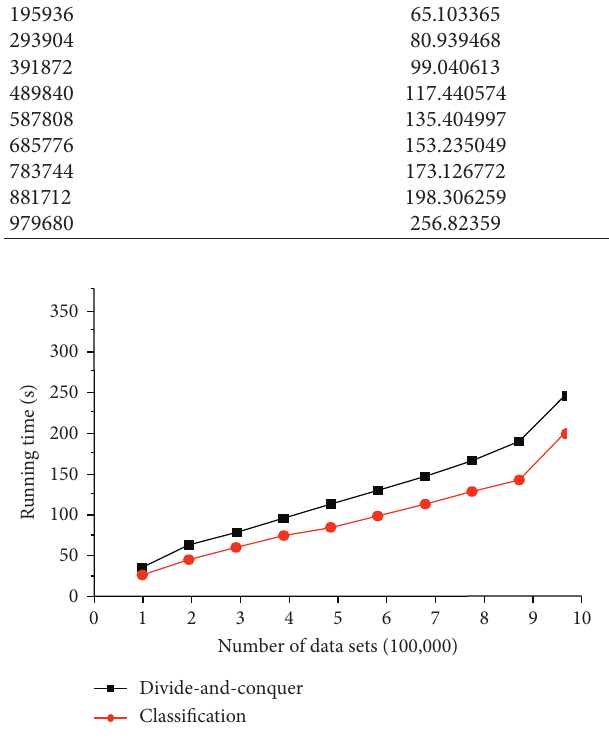
Figure 2: Running time of the two algorithms in parallel testing on different set.